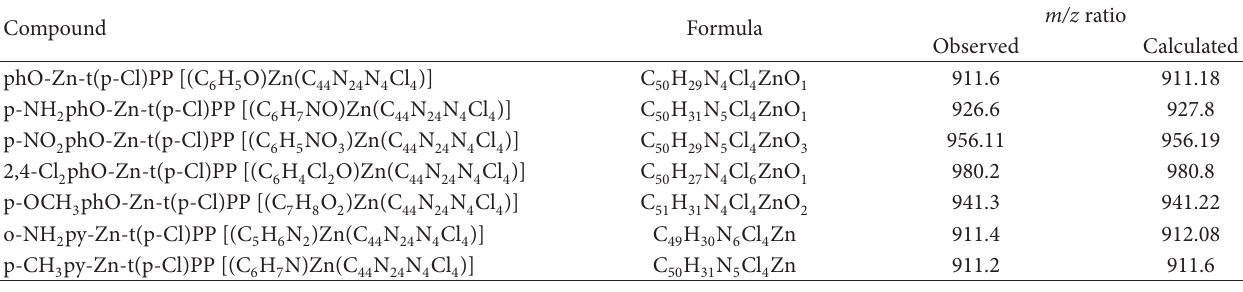
T 6: Mass data for X-Zn II -t(p-Cl)PP (X = phenolates and pyridinates as axial ligand). Compound Formula